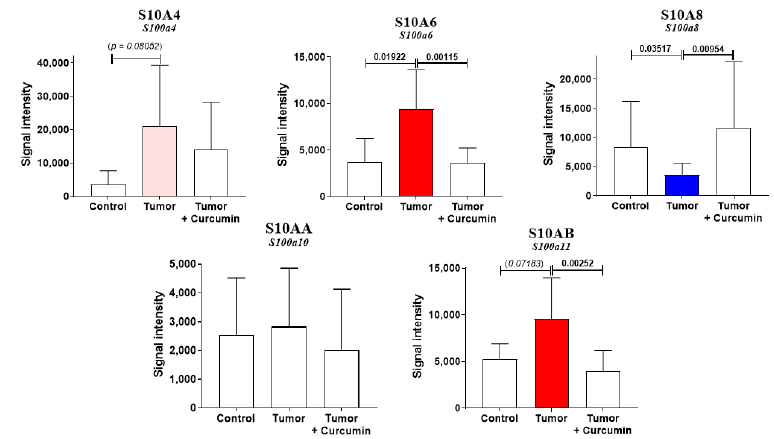
Figure 5. S100 di ff erential abundance proteins. Comparison of protein abundances between the three groups of rats (significant increases in red and decreases in blue, with p -values indicated above the bars). Blank bars correspond to the absence of significant di ff erences between groups. The p -values in italics and / or bars in light red correspond to tendencies ( p < 0.09).